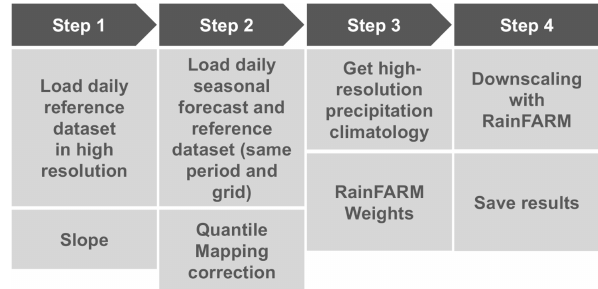
Figure 10. Scheme of the steps that need to be carried out to ob- tain and save a downscaled precipitation dataset. These steps are explained in detail in the text of the